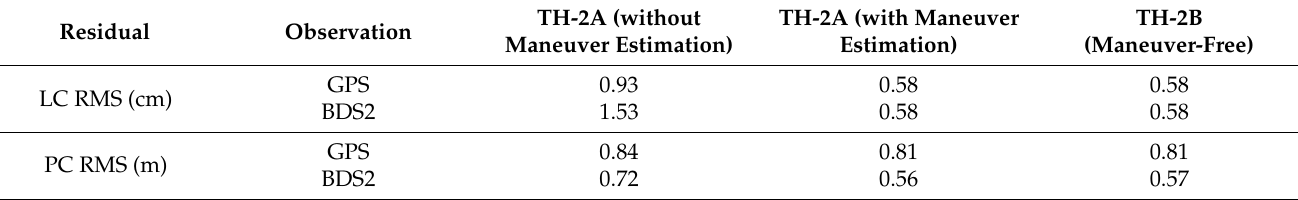
Table 2. Average RMS of PC and LC residuals of GPS- and BDS2-based POD for TH-2A (without maneuver estimation), TH-2A (with maneuver estimation), and maneuver-free TH-2B.